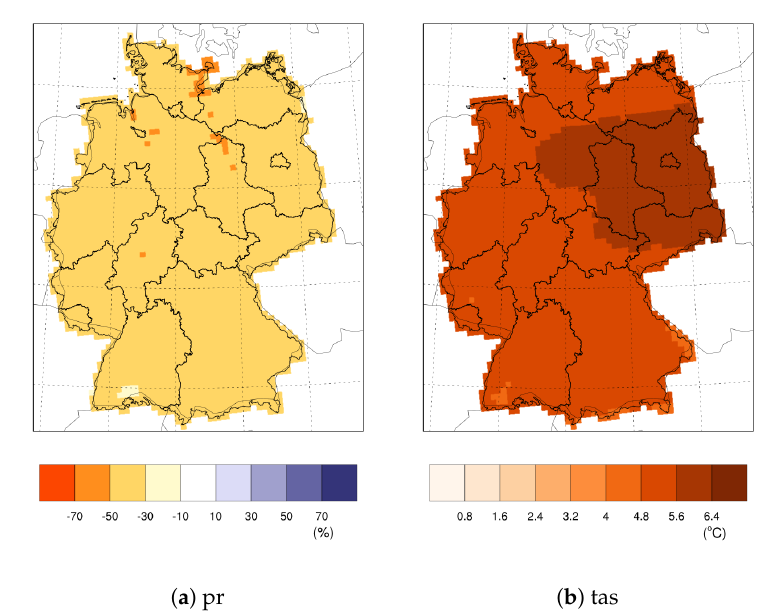
Figure 3. Downscaled results for the modeling chain SSP5-8.5—CanESM5 run1—EPISODES2018. Shown is the change between 2071–2100 and 1971–2000 (future minus past) for northern hemisphere summer (JJA) for ( a ) precipitation (pr) and ( b ) temperature